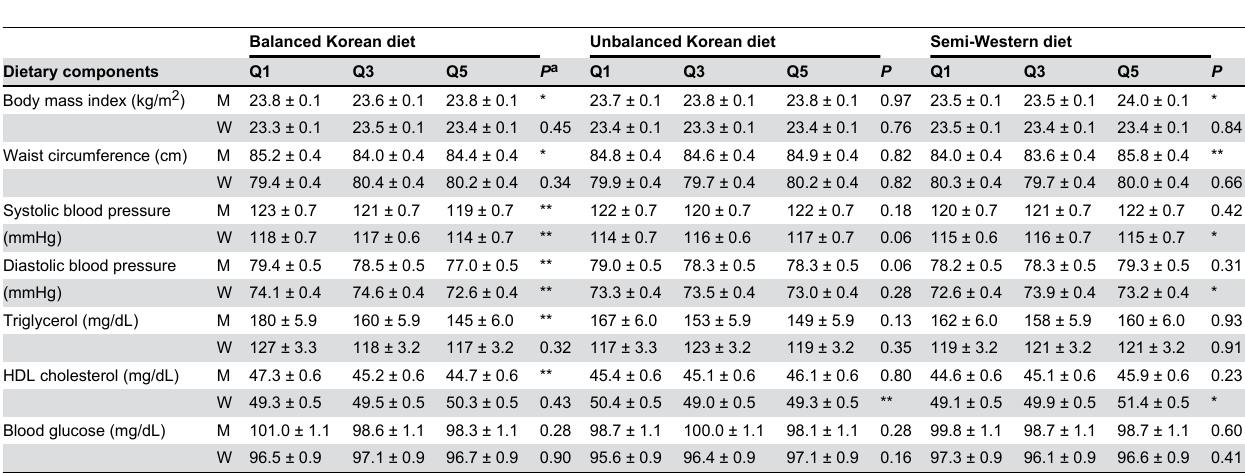
Table 3. Biochemical characteristics by the quintiles of major three Korean diets based on the KNANES 2007-2008 (n=5,320, 2,239 men and 3,081 women).